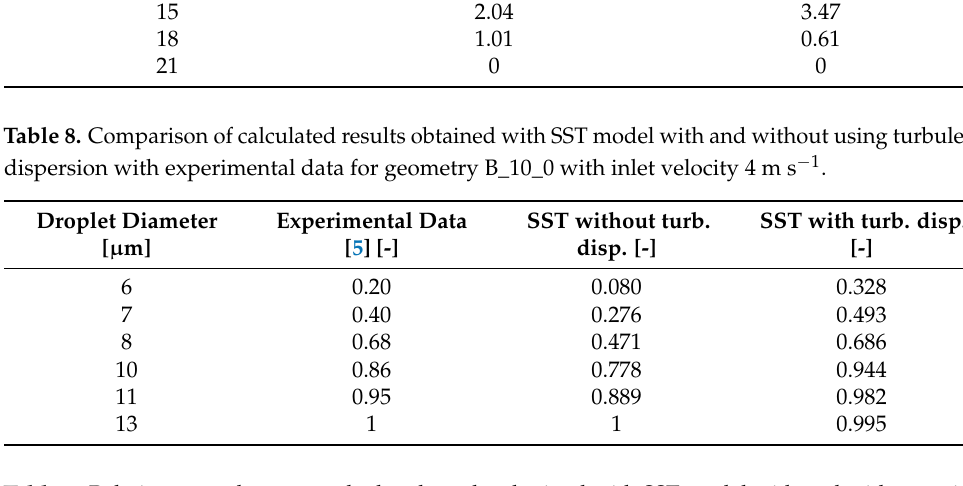
Table 9. Relative errors between calculated results obtained with SST model with and without using turbulent dispersion with experimental data for geometry B_10_0 with inlet velocity 4 m s − 1